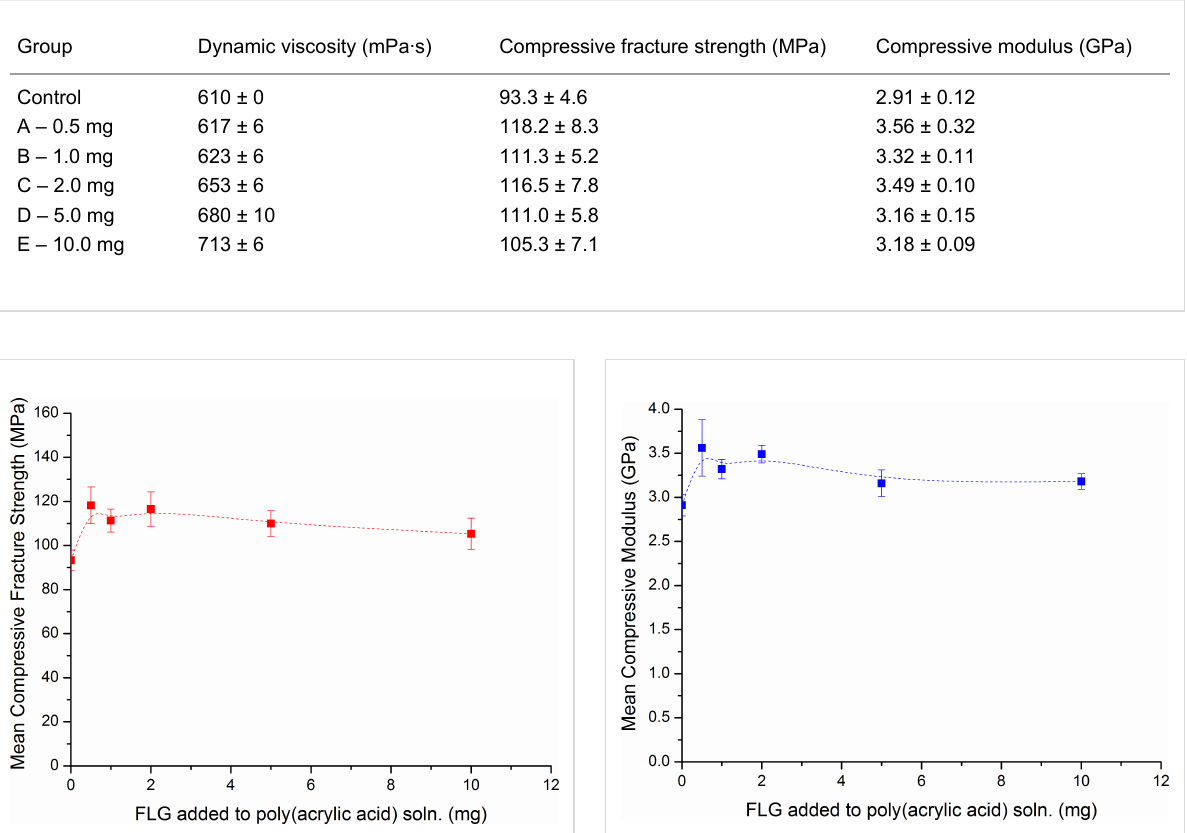
Table 2: The mean dynamic viscosity, compressive fracture strength and compressive modulus ± standard deviation for the control group and the groups prepared with poly(acrylic acid) solutions containing graphene.